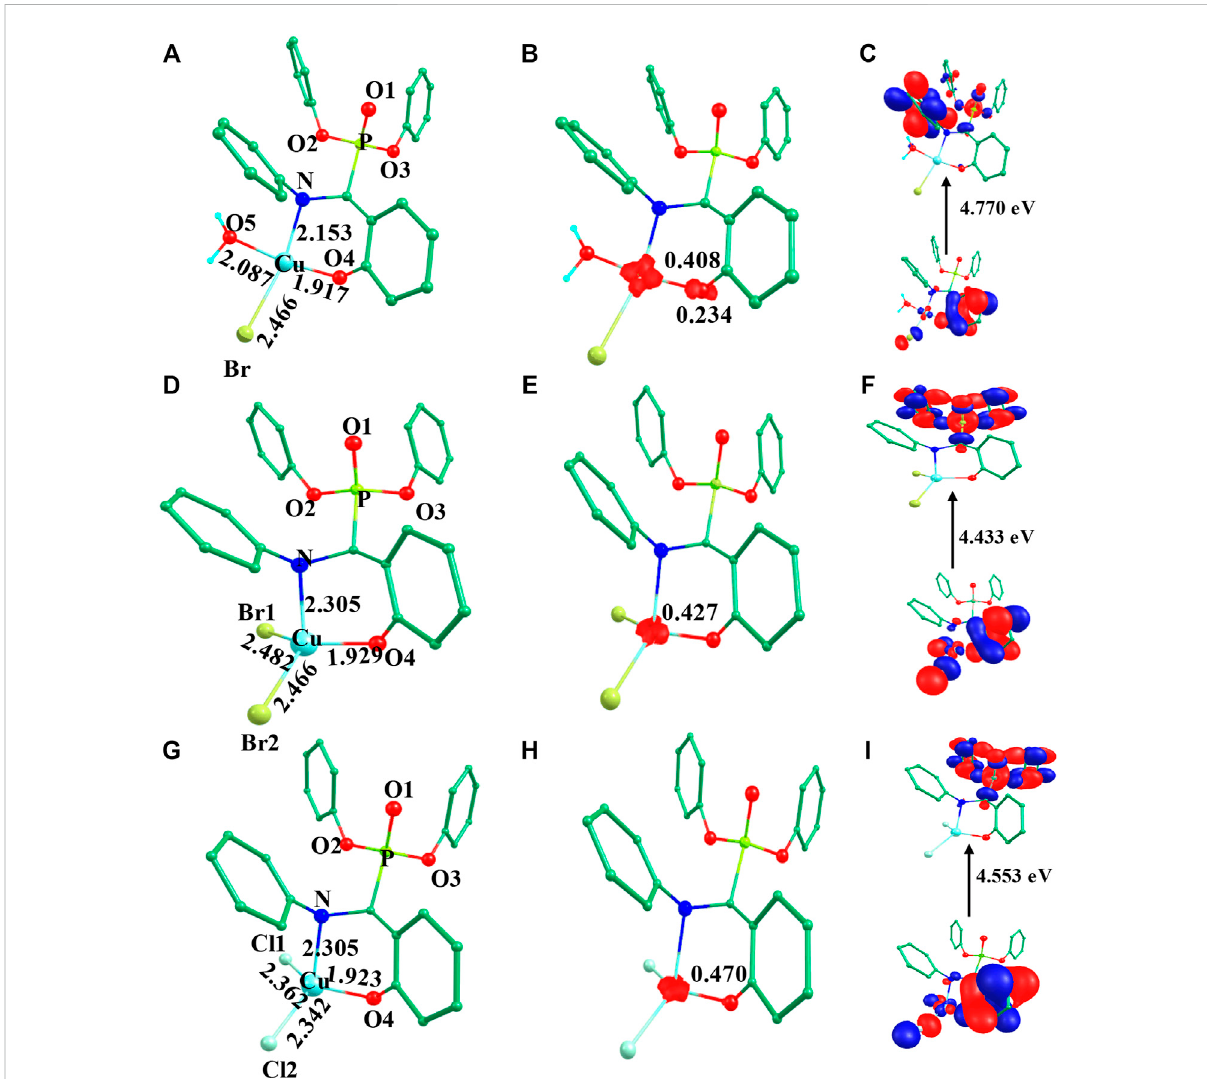
FIGURE 1 B3LYP-D2 (A) optimizedstructureofspecies I andits (B) spindensityplotand (C) HOMO-LUMOgap; (D) optimizedstructureofspecies II andits (E) spin density plot and (F) HOMO-LUMO gap; (G) optimized structure of species III and its (H) spin density plot and (I) HOMO-LUMO gap. (Bond lengths are in